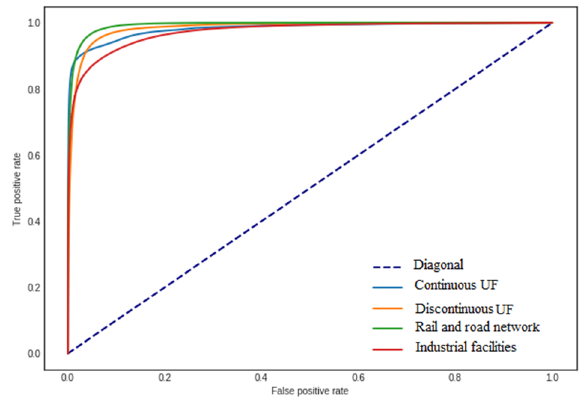
Figure 12. ROC curve per urban fabric (UF) class. Figure 12 . ROC curve per urban fabric (UF) class.